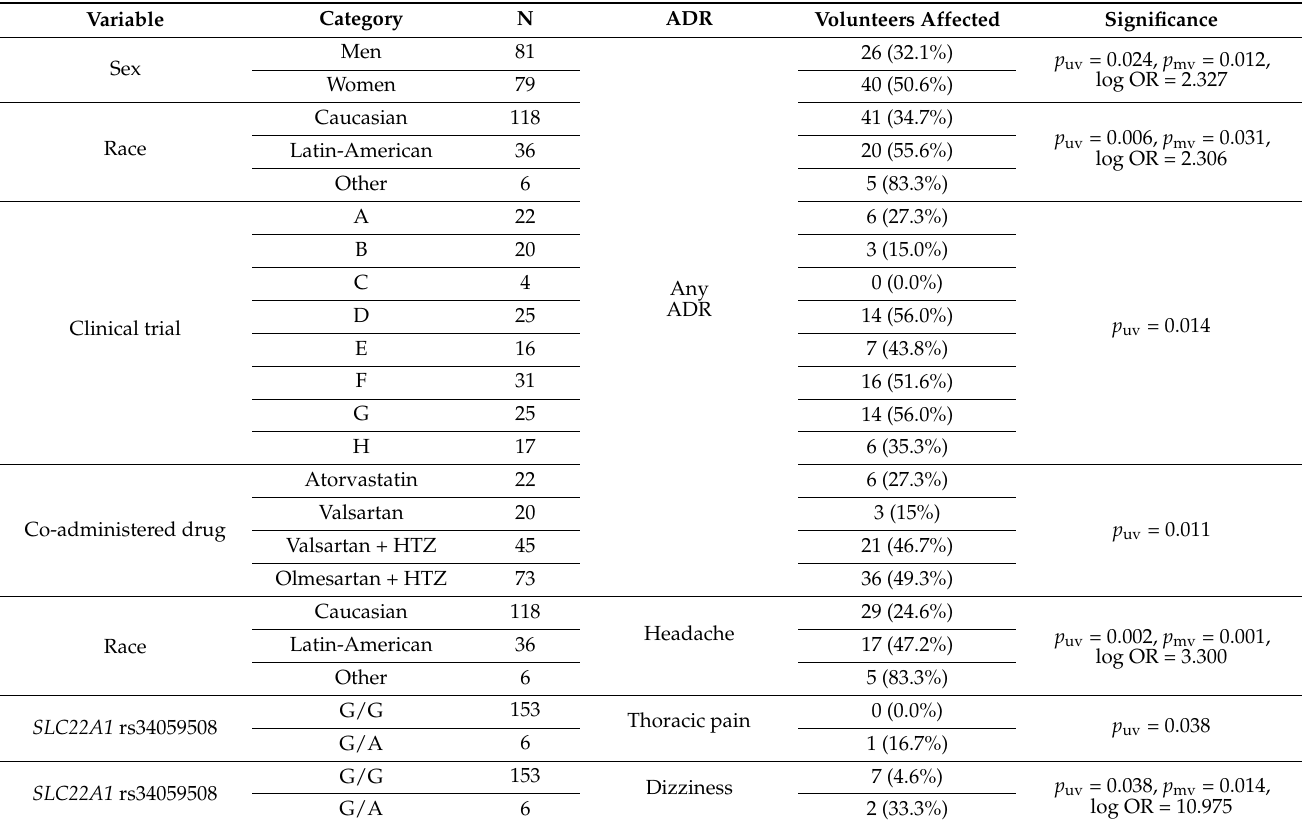
Table 6. Significant differences in the incidence of ADRs according to clinical trial design, demo- graphic characteristics and pharmacogenetic